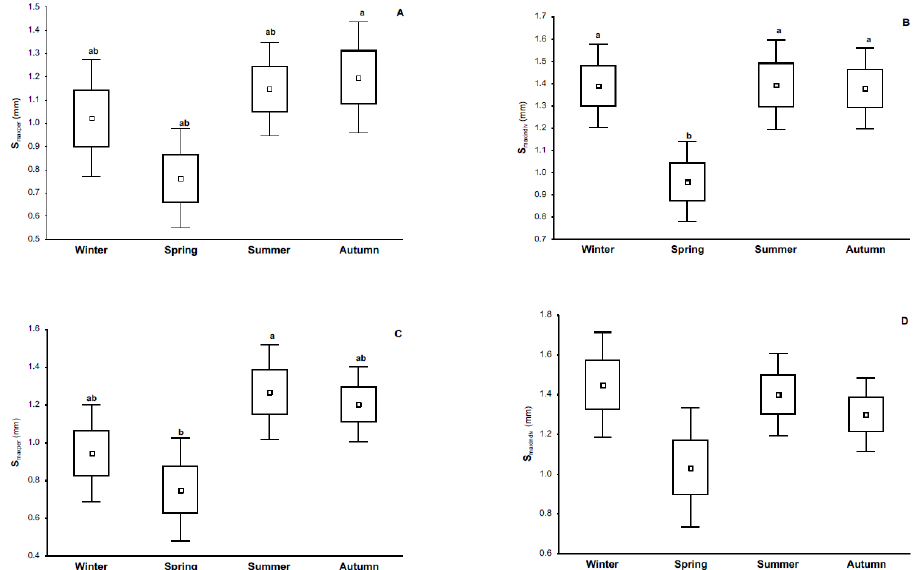
Figure 2. Swelling index 6 h after injection of phytohemagglutinin (S maxper ) in female ( A ) and male ( C ) fish-eating myotis in Partida Norte Island, Mexico, and maximum swelling value registered for each individual within the 3–12-h period after injection (S maxindiv ) in females ( B ) and males ( D ). Values are mean (square), standard error (box), and minimum and maximum values (whiskers). Only significant differences after factorial analysis of variance are pointed out using different letters.